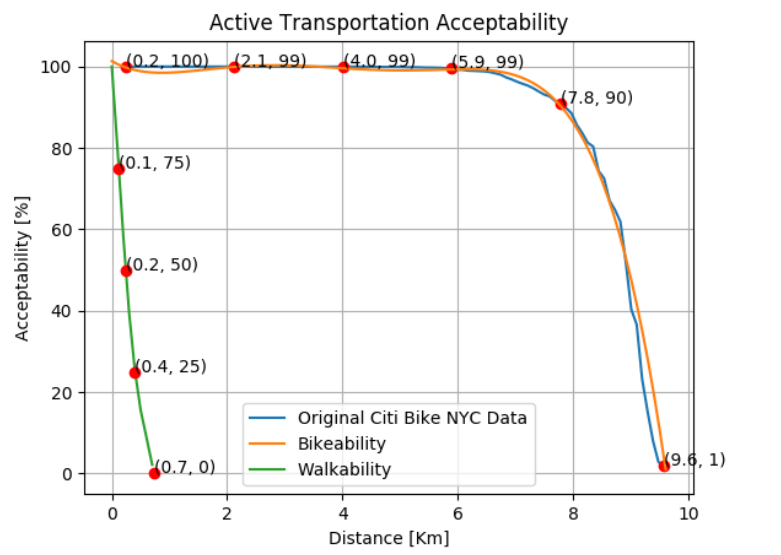
Figure 8. Normalized cumulative distribution function for bike trips using the Citi Bike NYC service in